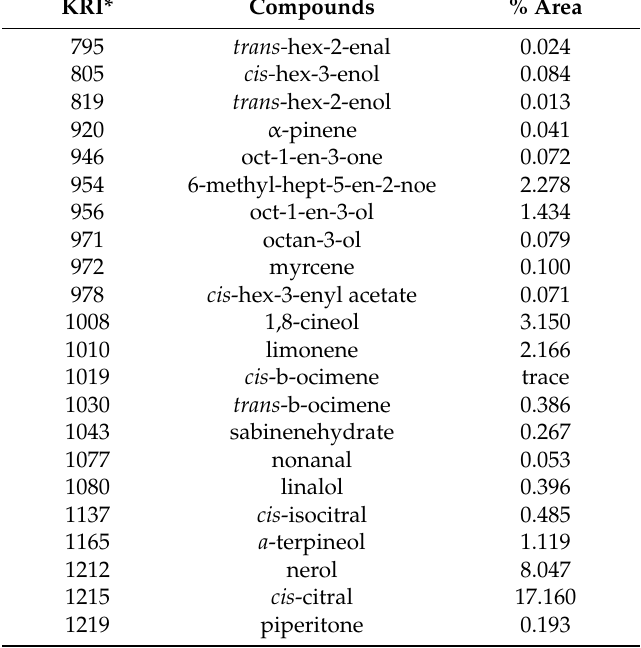
Table 1. Volatiles identified in the essential oil of Lippia citriodora and their relative percent (%)